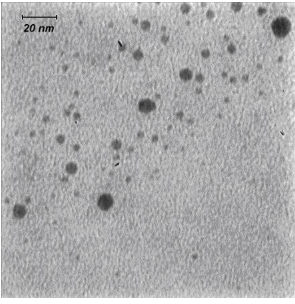
Fig. 1. Transmission electron microscopy (TEM) micrograph